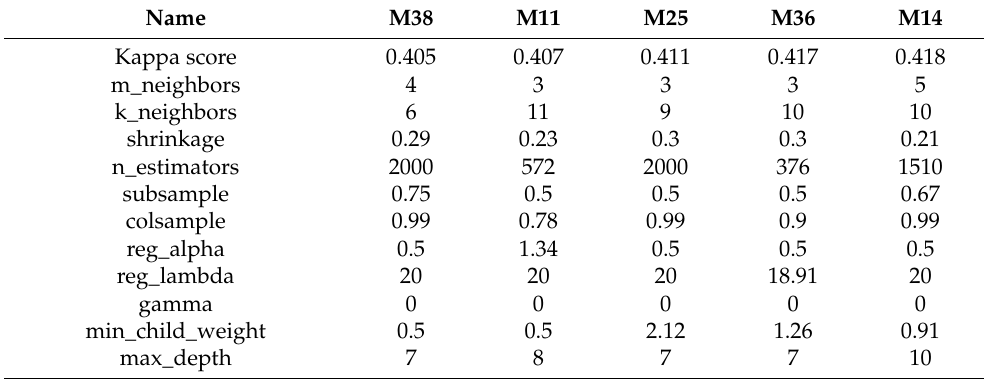
Figure 4. Variation of cross-validation kappa scores over Bayesian optimization iteration numbers. Table 6. Top performed hyperparameter sets, the corresponding cross-validation kappa scores, and specific values of the tuned hyperparameters. The numbers after “M” denoting the iteration numbers.